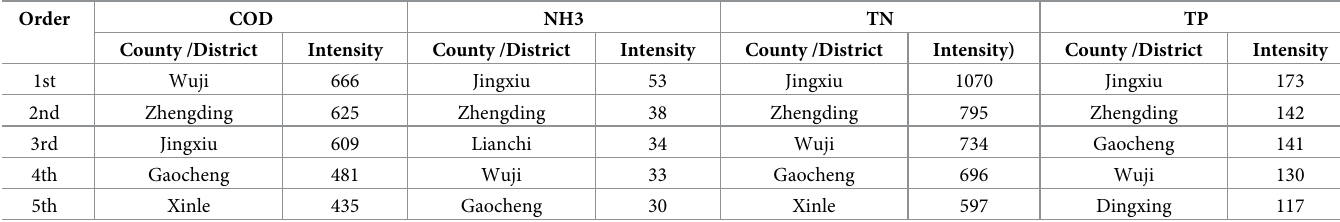
Table 5. Classification of counties with higher pollution intensity of different pollutants (Kg/ha).